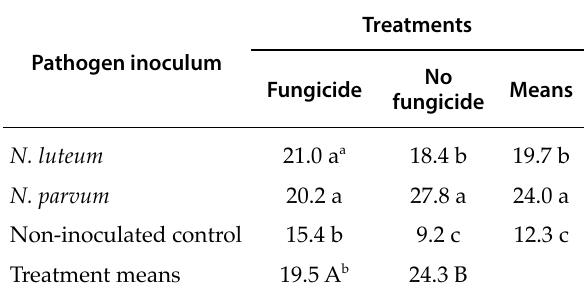
Table 1. Mean incidence (%) of infection in dormant grape- vine canes for which the trimming wounds of the shoots had been treated during the growing season with the fun- gicide flusilazole prior to inoculation with Neofusicoccum luteum and N. parvum .